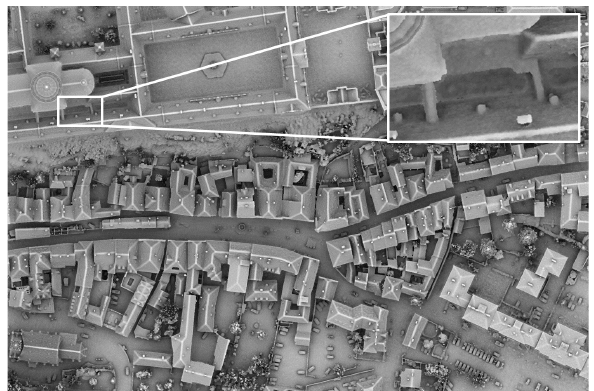
Figure 8. Comparison of a complex profile, (a) plan view of RGB colored DIM point cloud, (b) section view, LiDAR points